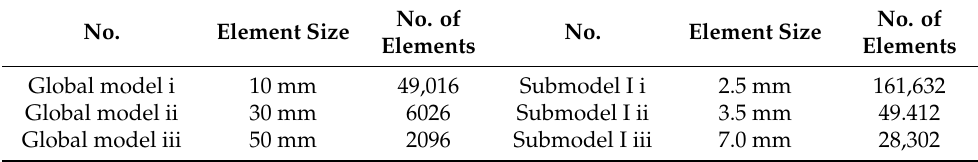
Table 4. Griding partition details of global model and submodel I.